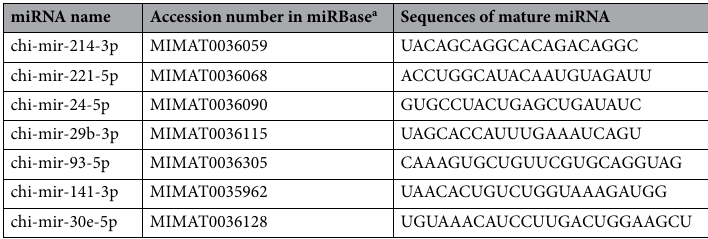
Table 1. Sequences of mature miRNA and miRBase accession number. a miRbase 44